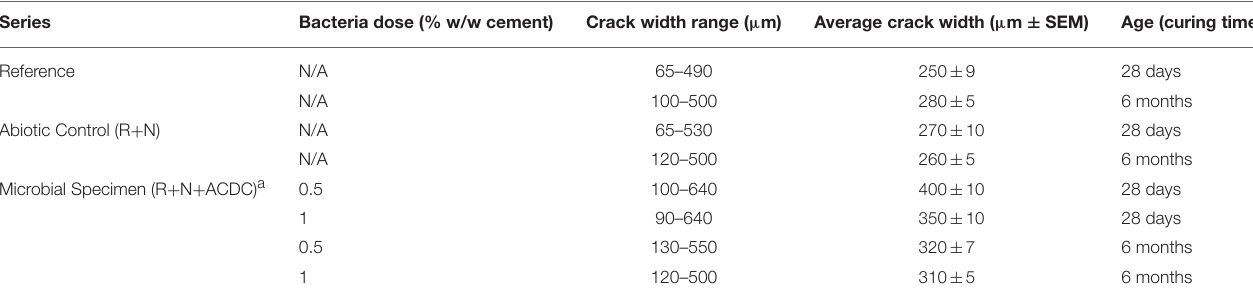
TABLE 2 | Detailed information about the specimen series tested throughout the study.